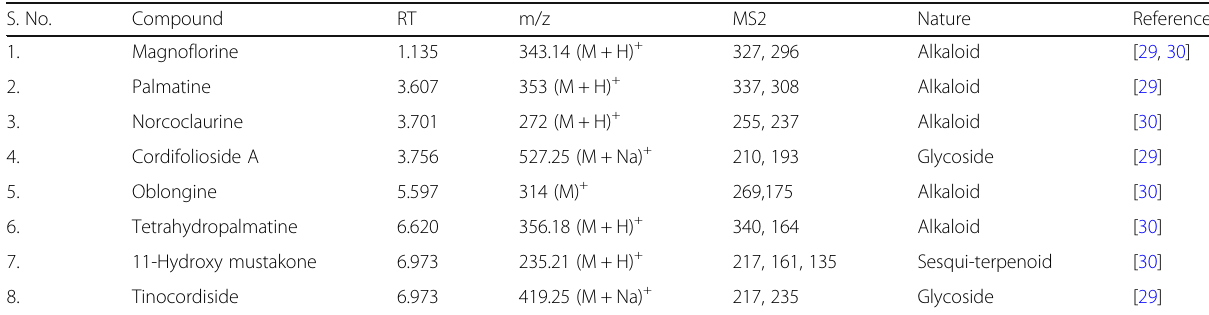
Table 1 UPLC-MS analysis: Observed molecular weight and mass fragments of identified compounds in B-TCE extract S.